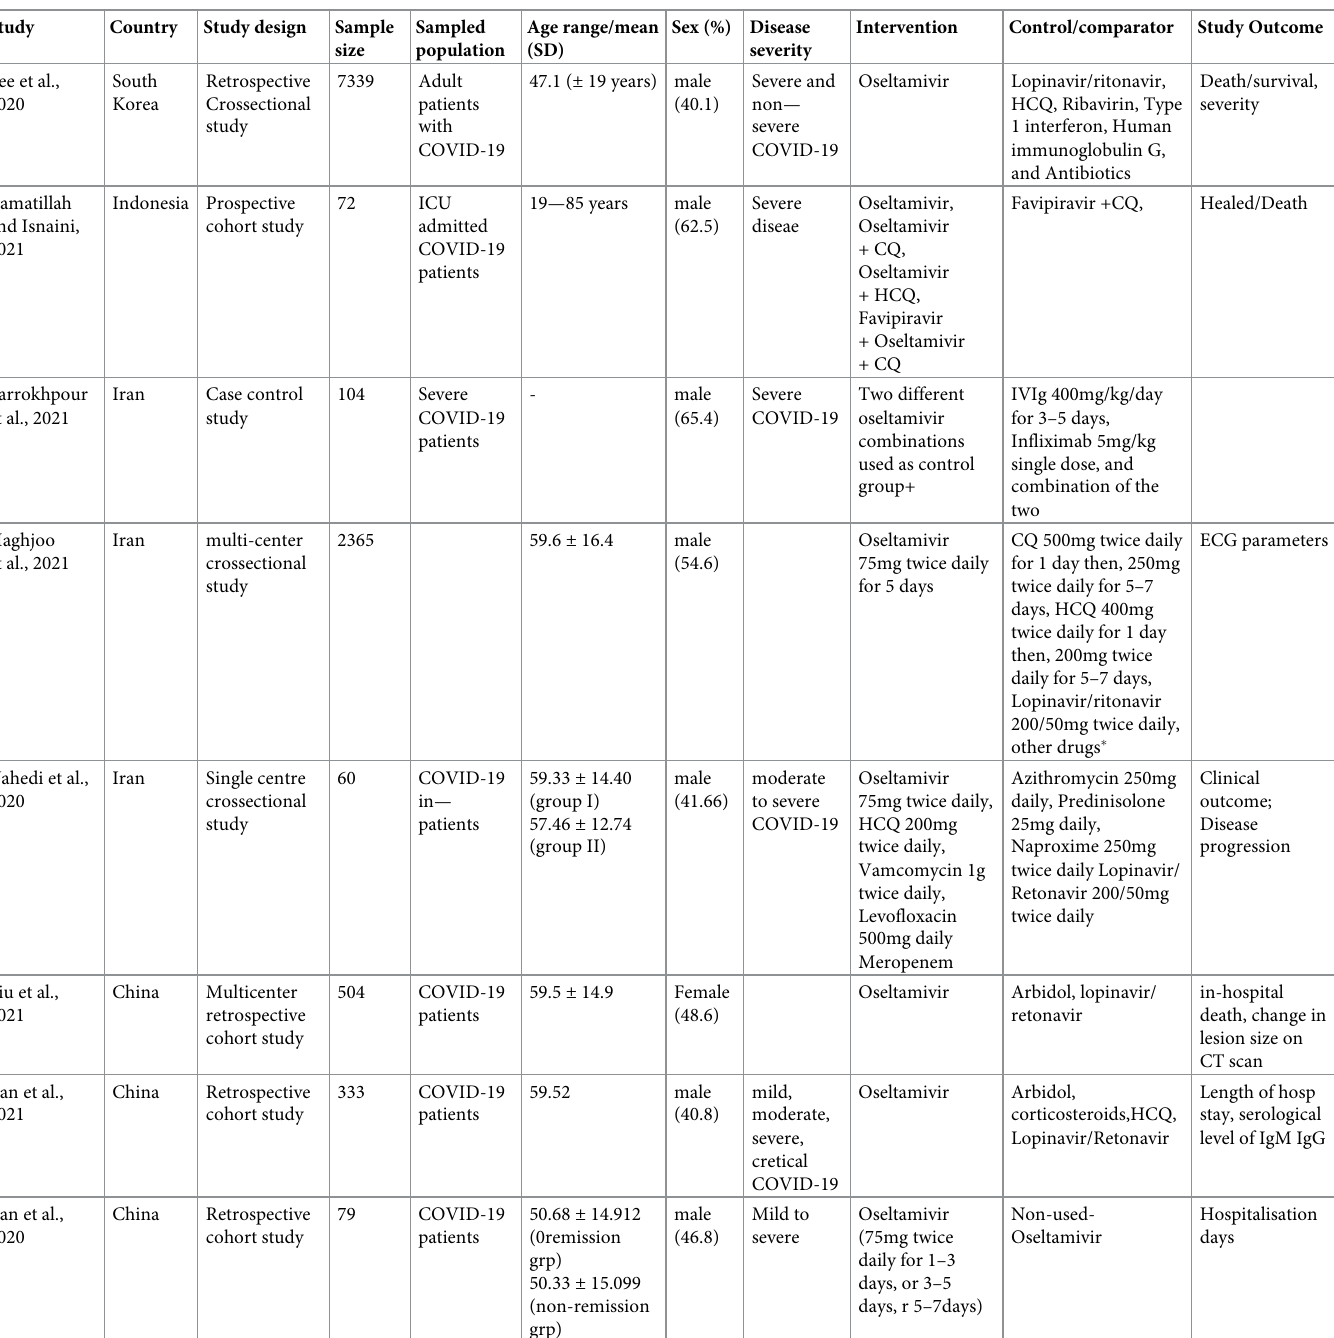
Table 1. Characteristics of included